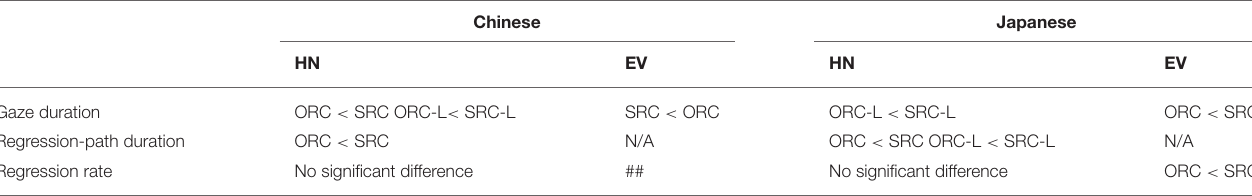
TABLE 5 | Summary Table: results of clause type, and clause type ×